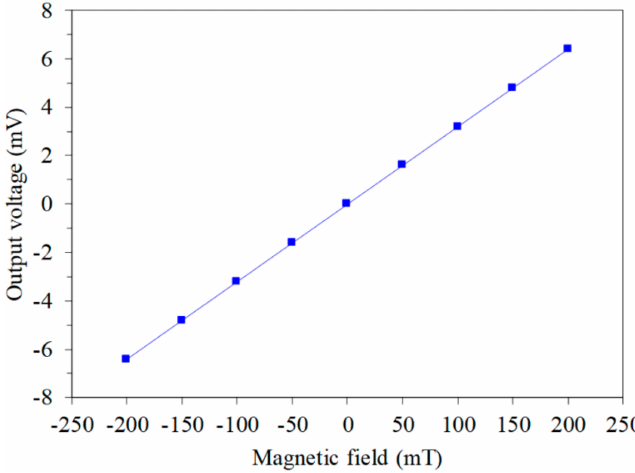
Figure 4. Simulated OV in the z -axis magnetic